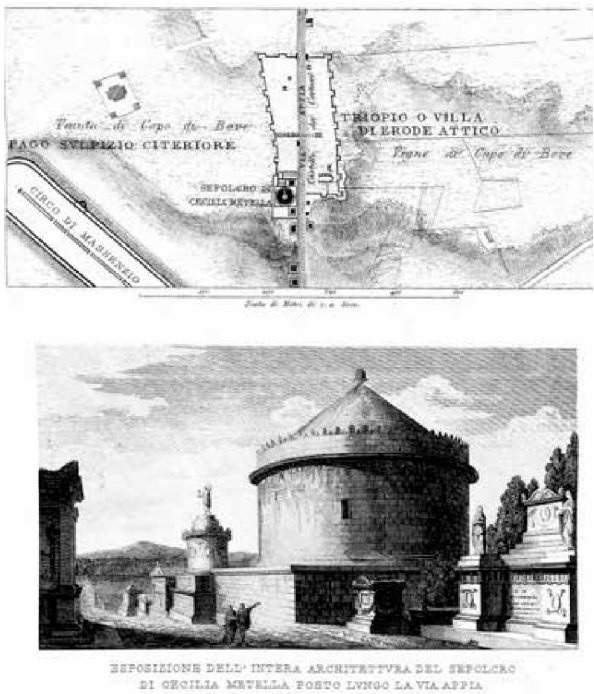
Figure 5. The research case study and the Appian way. Source: Luigi Canina 1853, tav.